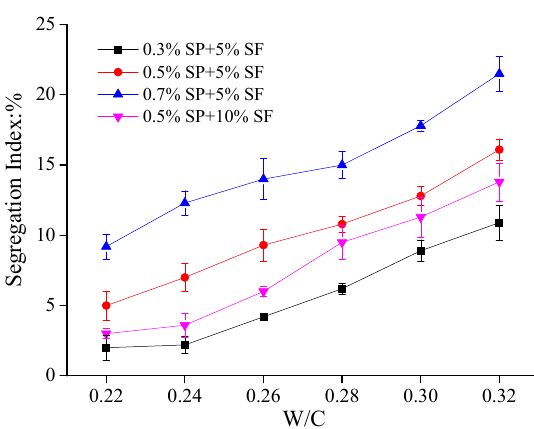
Figure 4. Segregation index of pervious concretes. (Three concrete specimens were prepared for each mix design and the figure shows an average of these together with the standard deviation).